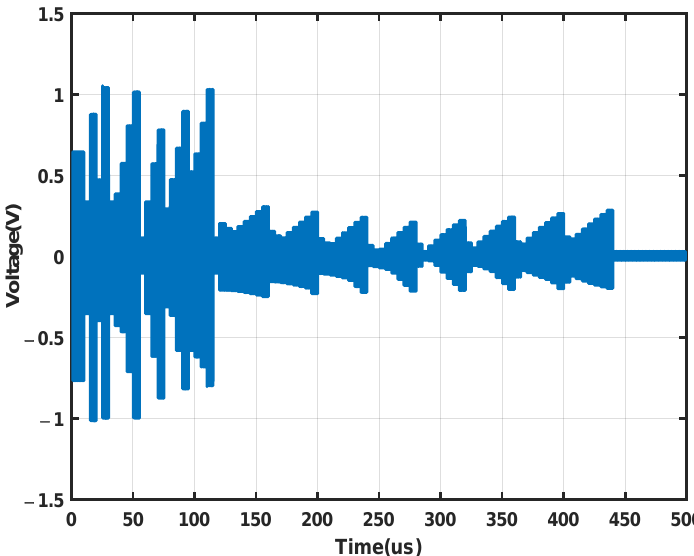
Figure 17. Simulation result of the differential output of the SJC circuit.